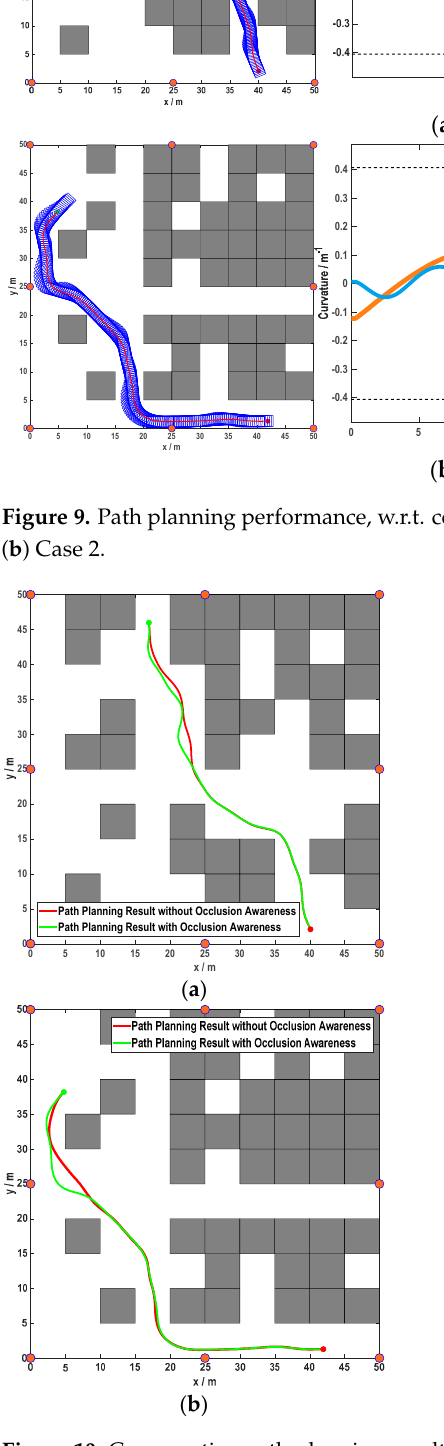
Figure 10. Comparative path planning results, w.r.t. occlusion awareness: ( a ) Case 1; ( b ) Case 2.